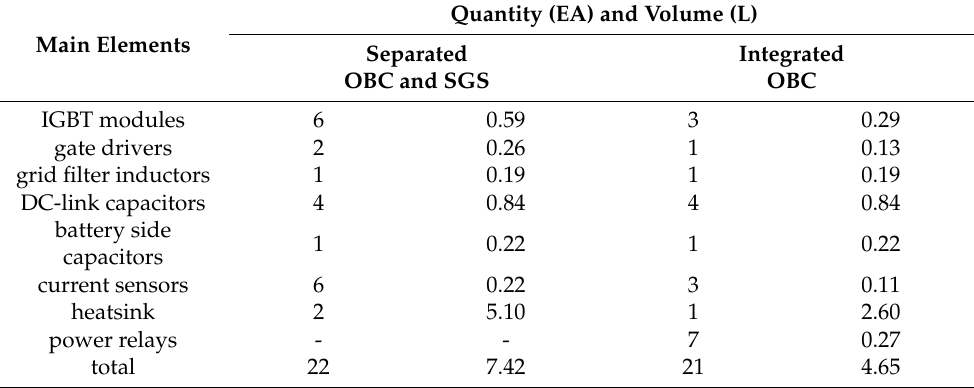
Table 1. Comparison of main elements quantity and volume in HEV.